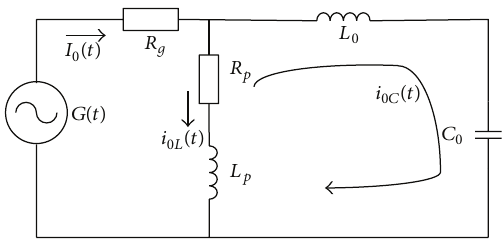
Figure 1: Zero sequence equivalent